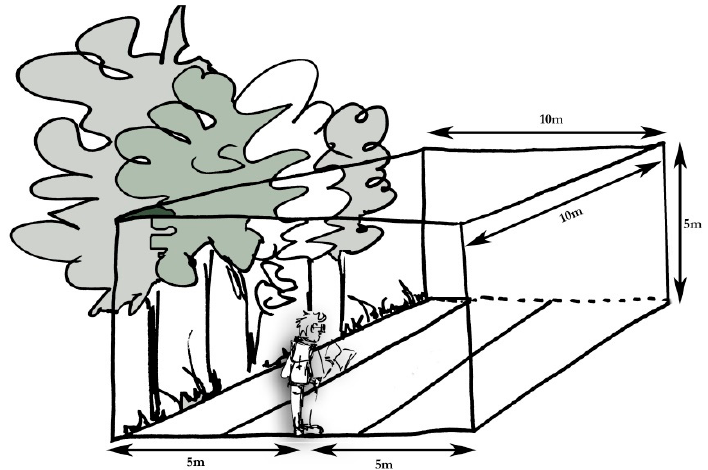
Figure 1. Representation of the virtual box around the surveyor; stag beetles observed within this virtual box are noted. Drawing made by Studiolae.